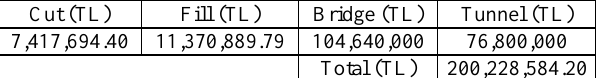
Table 15. Total length of engineering structures required for the construction of an alternative line on rolling land